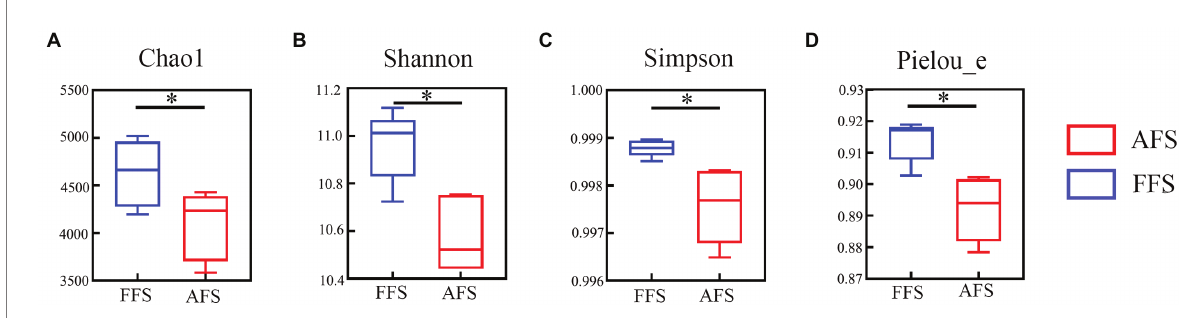
FIGURE 2 Alpha diversity of soil bacterial communities (A-D) in the FFS and the AFS. * p < 0.05, mean ± SD, Kruskal-Wallis test.